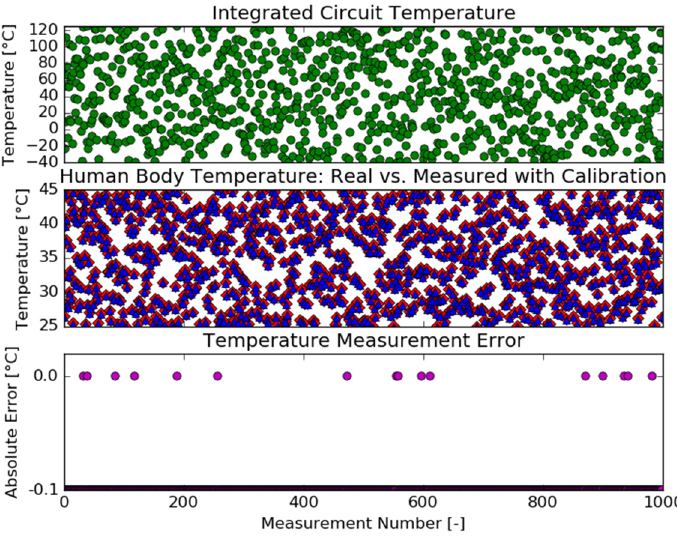
Figure 17. Process corner simulations with temperature calibration technique.